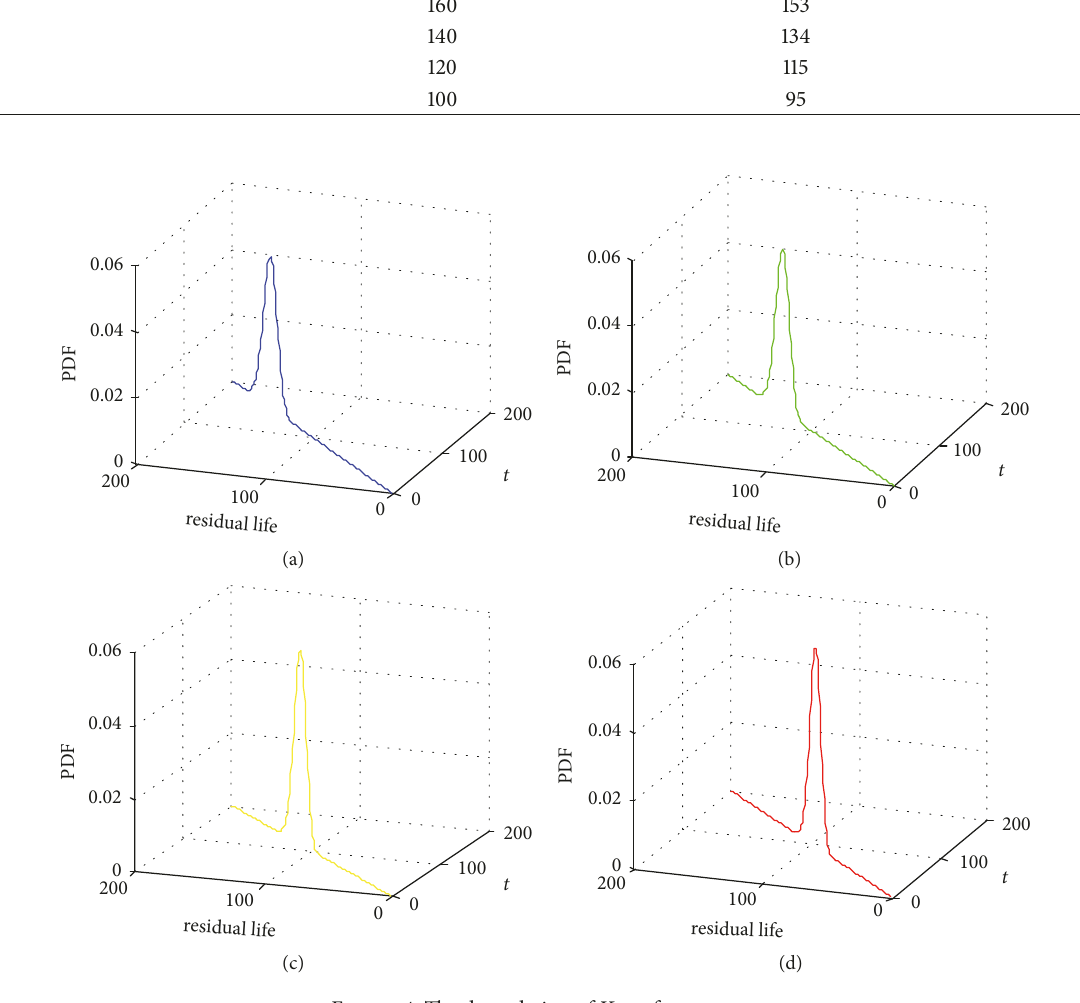
Figure 4: The degradation of 𝐾𝑠𝑥 of